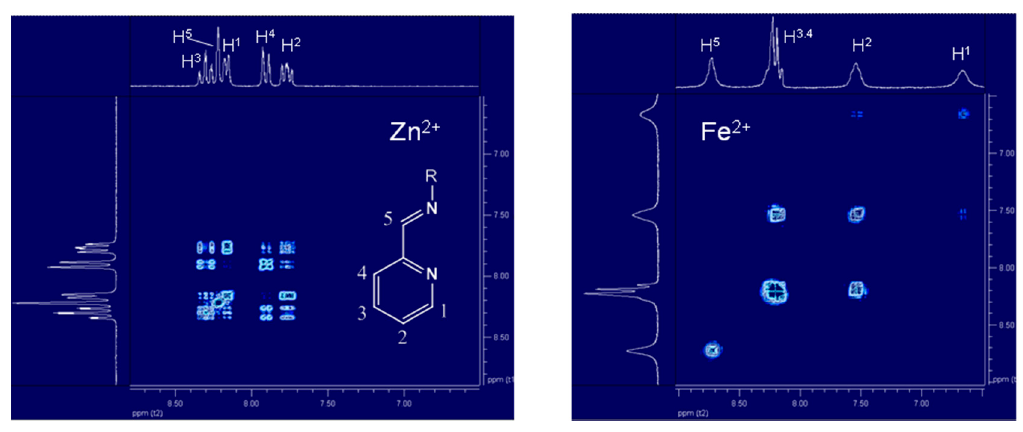
Figure 2. 1 H-NMR COSY spectra (200 MHz; D 3 -MeCN) at ambient temperature; ( left ) [ZnL] (ClO 4 ) 2 ; ( right ) [FeL] (BF 4 ) 2 ; inset: assignment of proton sites.